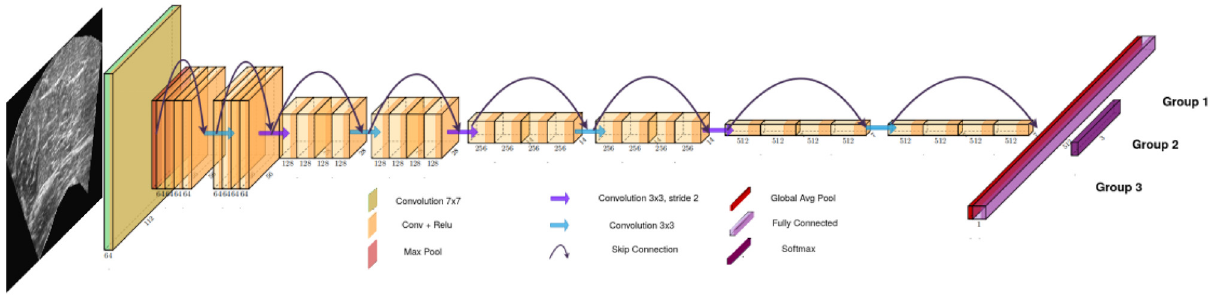
Figure 7. The Resnet18 classifier. For each image input, the classifier predicts which group the tex- ture belongs